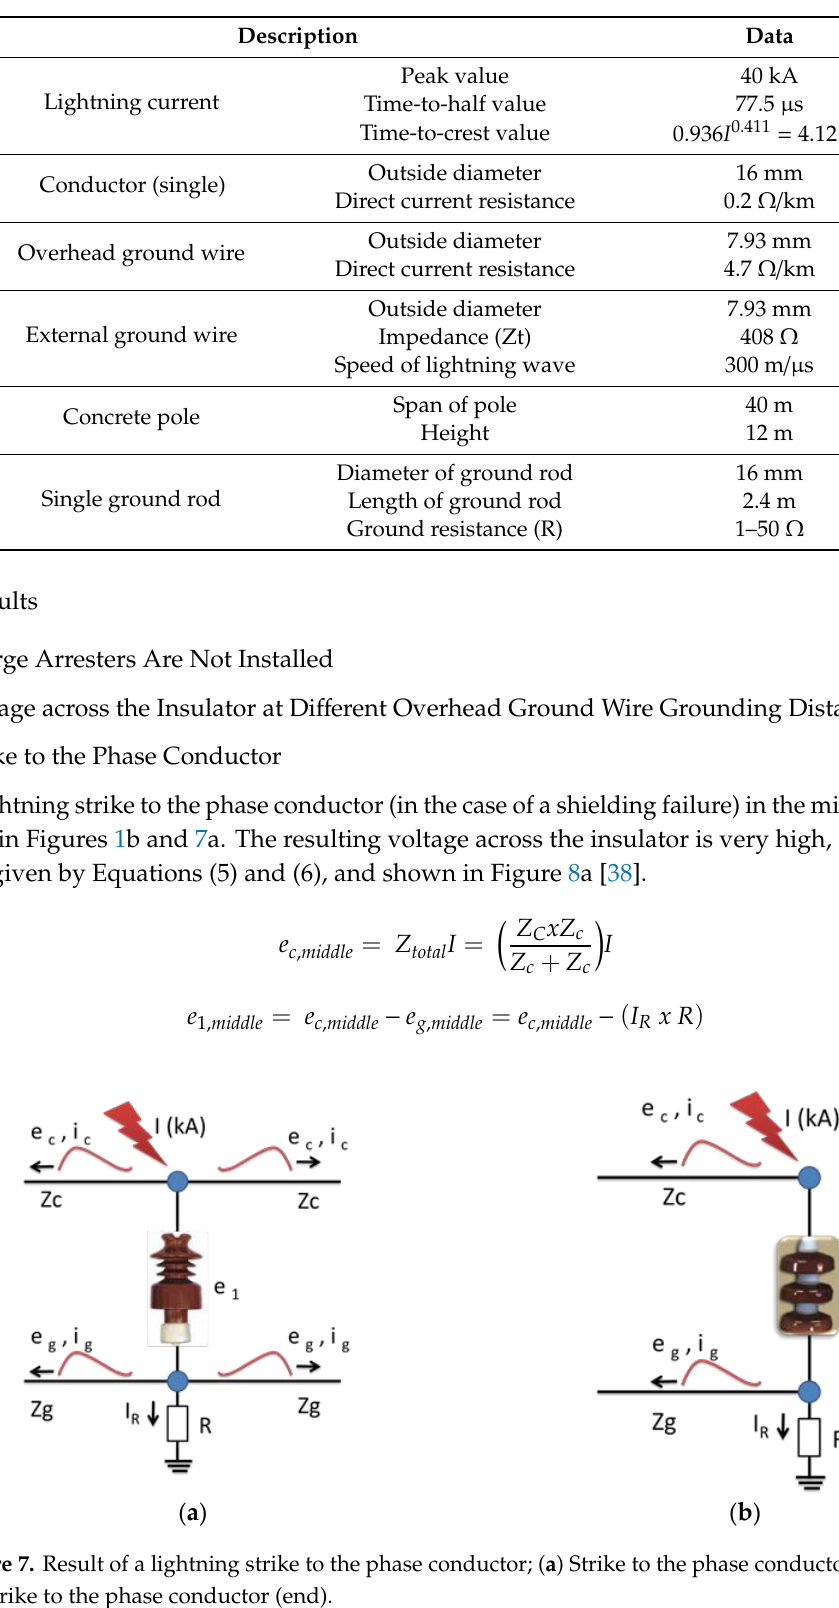
Table 4. Parameters used for the design.